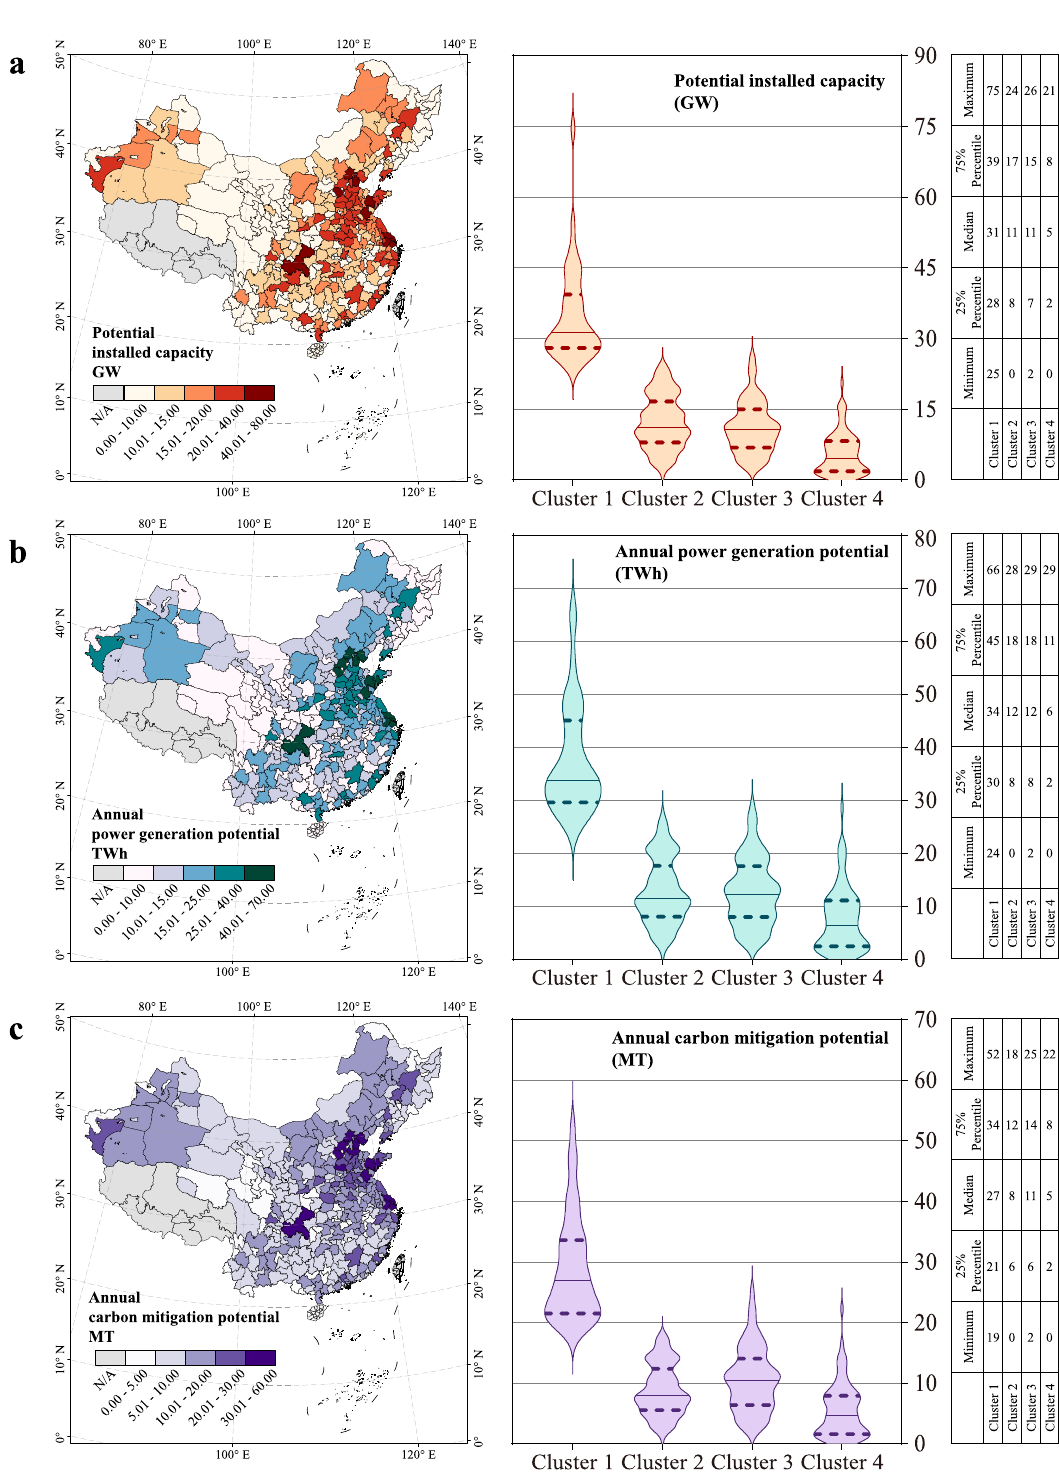
population and a productive economy, representing the largest installed and power generation scale, with a contribution of 29% of the total carbon mitigation potential, while Cluster 4 accounted for only 11%. Data Credits: All the city admin- istrative boundaries are from